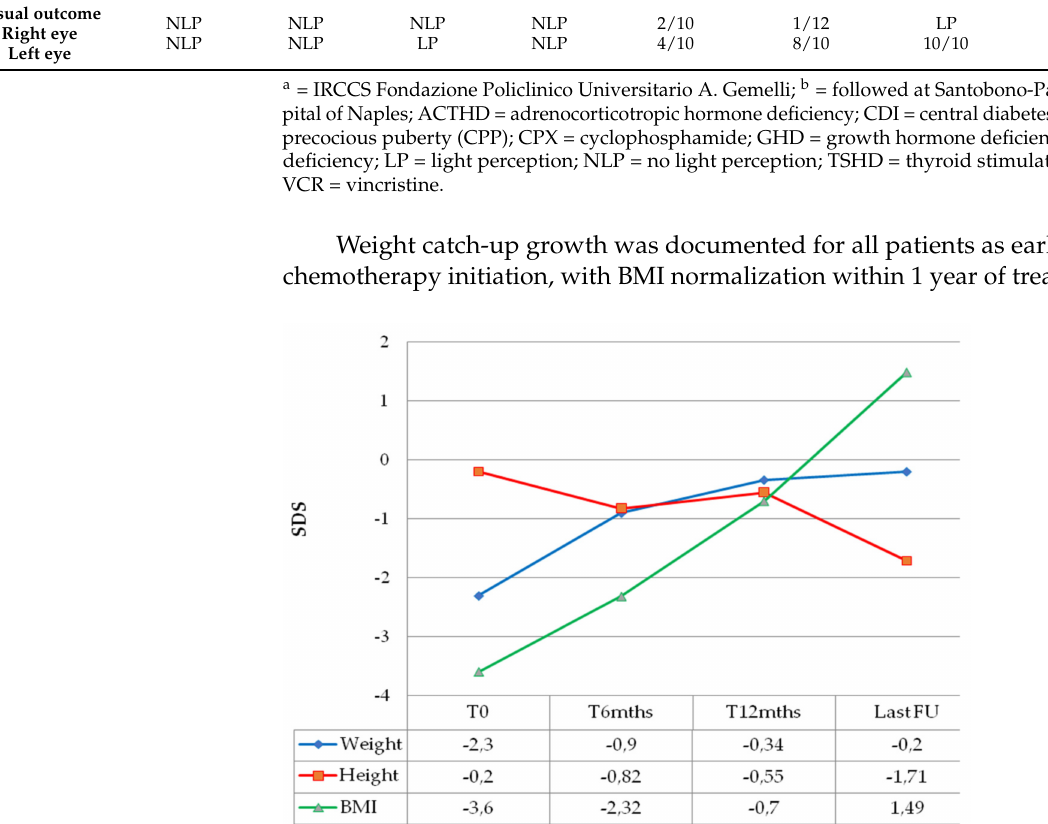
Figure 1. Median anthropometric changes over time of children with optic pathway glioma and diencephalic